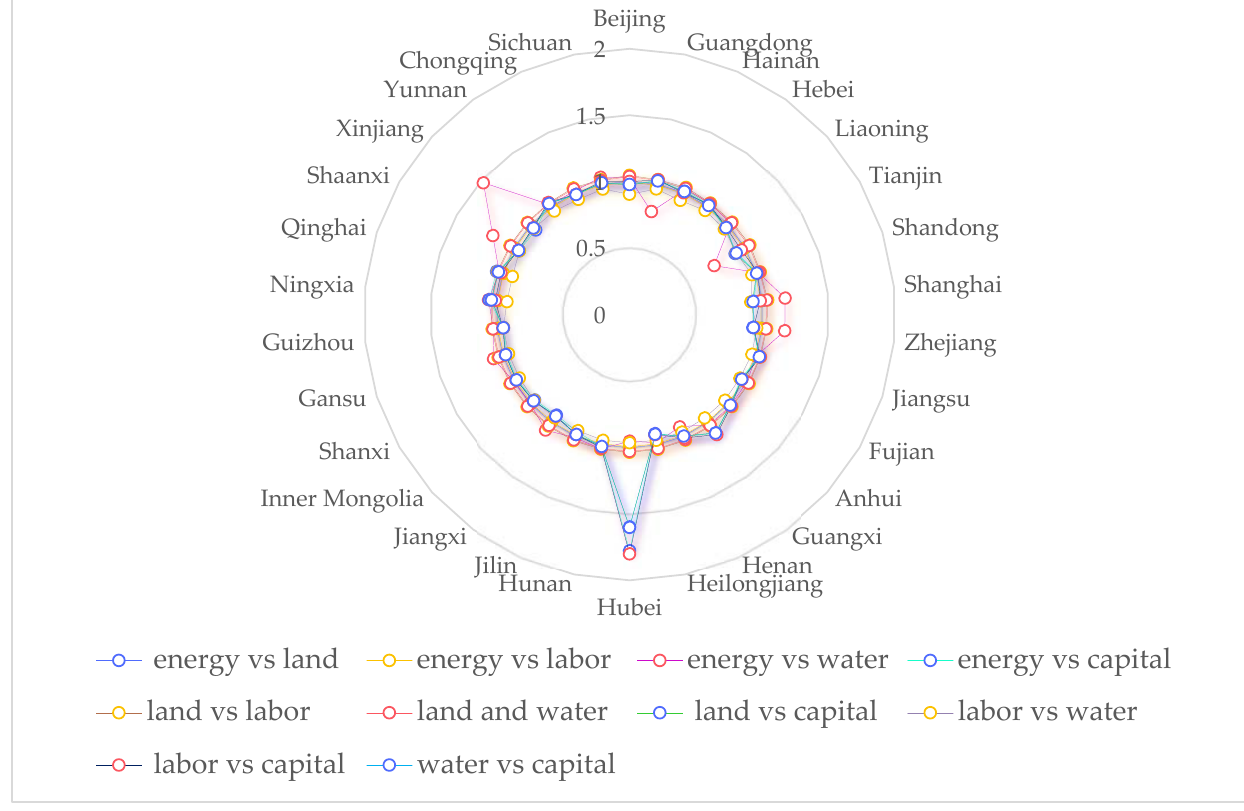
Figure 5. Elasticity of substitution between elements. Table 7. Substitution relationships between different factors of